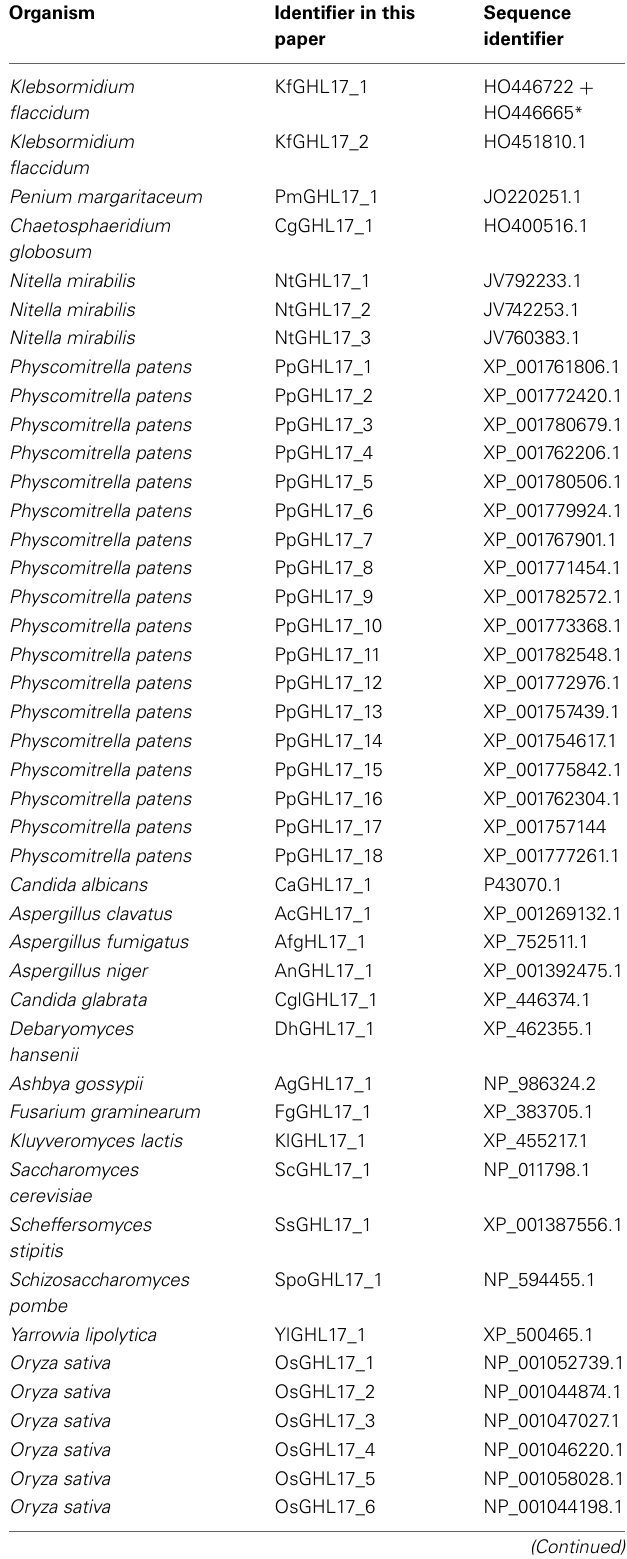
Table 1 | List of sequences used for constructing the phylogenetic